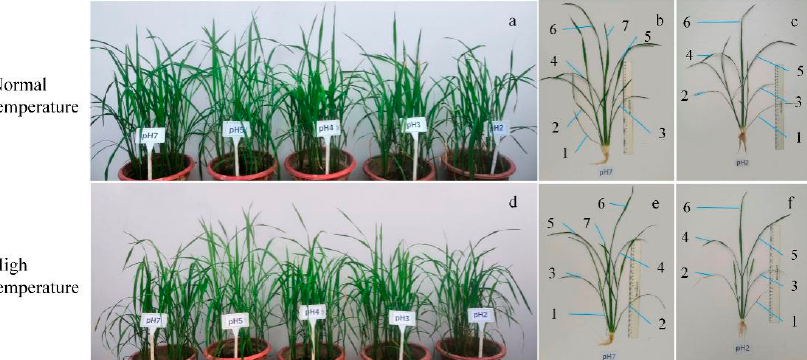
Figure 2. Rice seedlings exposed to different pH acid rain for 7 days under normal- and high- temperature conditions. ( a – c ) The seedlings under normal-temperature conditions. ( d – f ) The seedlings under high-temperature conditions. ( a , d ) Rice seedlings exposed to acid rain treatments under different temperature conditions. pH 2, 3, 4, 5, and 7 in Panel a and d indicate treatment with acid rain of pH 2, 3, 4, 5, and deionized water, respectively. ( b , e ) Seedlings after pH 7 treatment. ( c , f ) Seedlings after pH-2 treatment. The numbers in the panel ( b , c , e , f ) indicate complete expanded leaves of seedlings.